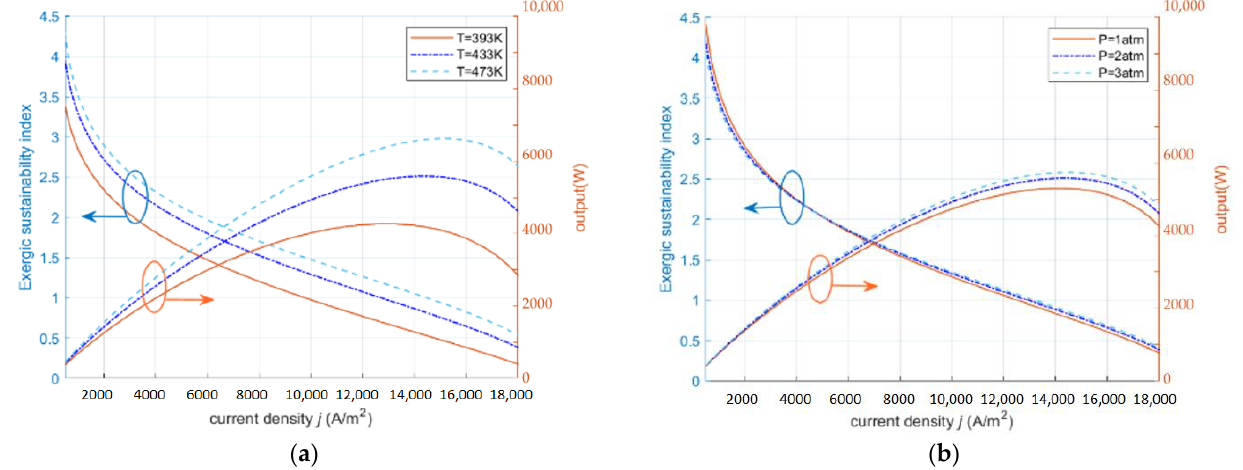
Figure 4. The effect of operating parameters on the exergy sustainability index and power density ( 𝑅𝐻 = 0.038 , 𝑡 𝑚𝑒𝑚 = 0.002 cm,𝐷𝐿 = 10 ). ( a ) different T; ( b ) different 𝑃 .